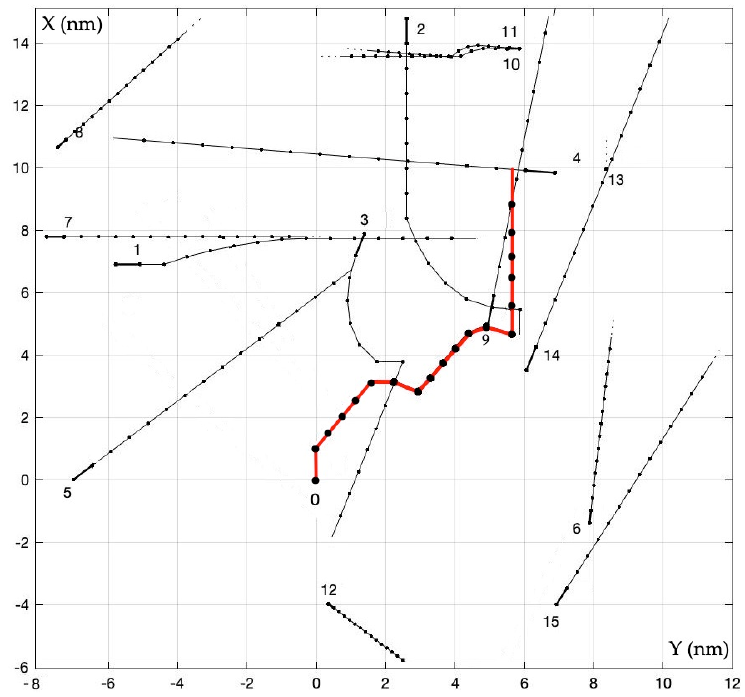
Figure 8. Trajectories of ships in non ‐ cooperative positional game ANCPGC.